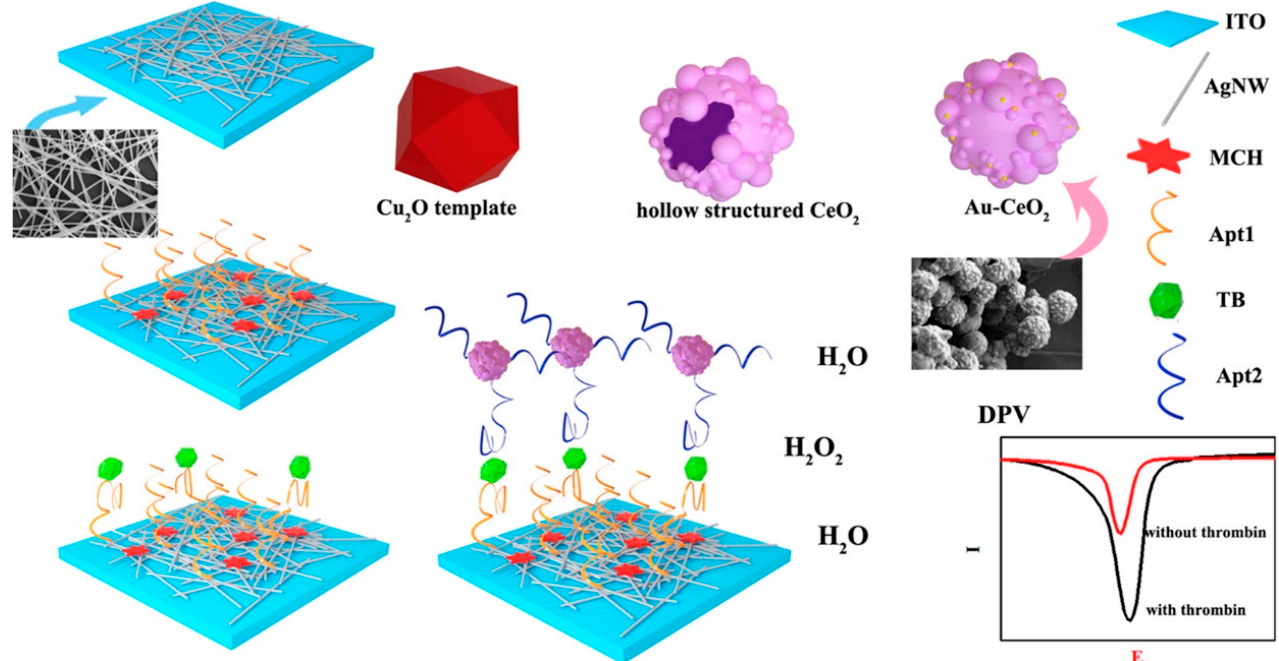
Figure 3. Schematic of an electrochemical assay for thrombin (TB) based on indium tin oxide electrodes (ITO) first modified with Ag nanowires (AgNW) onto which the capture aptamer is bound along with mercaptohexanol (MCH). The Cu 2 O particle is a template for formation of hollow CeO 2 particles that are decorated with Au nanoparticles. Detection of catalysis of reduction of H 2 O 2 by CeO 2 is done using differential pulse voltammetry. Reprinted with the permission from reference [54]. Copyright Elsevier 2020. Table 1. Electrochemical Sandwich Assays for Thrombin using